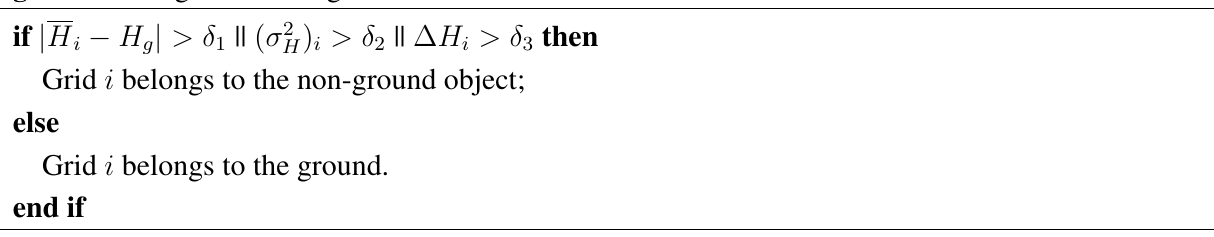
Algorithm 1 Segmentation: ground.